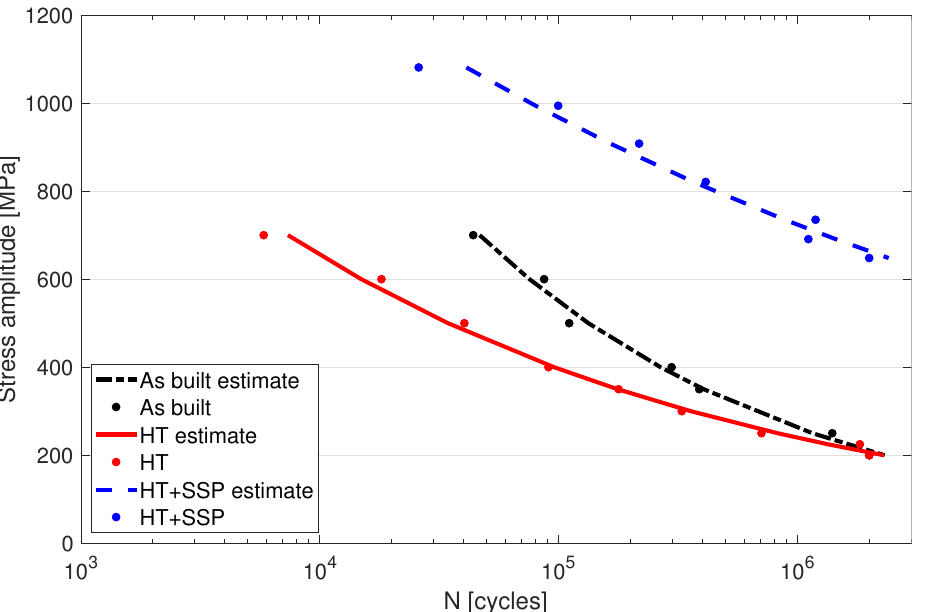
Figure 7. Stress amplitude and the corresponding fatigue lives for as built, heat treated, and severe shot peened after heat treatment conditions.